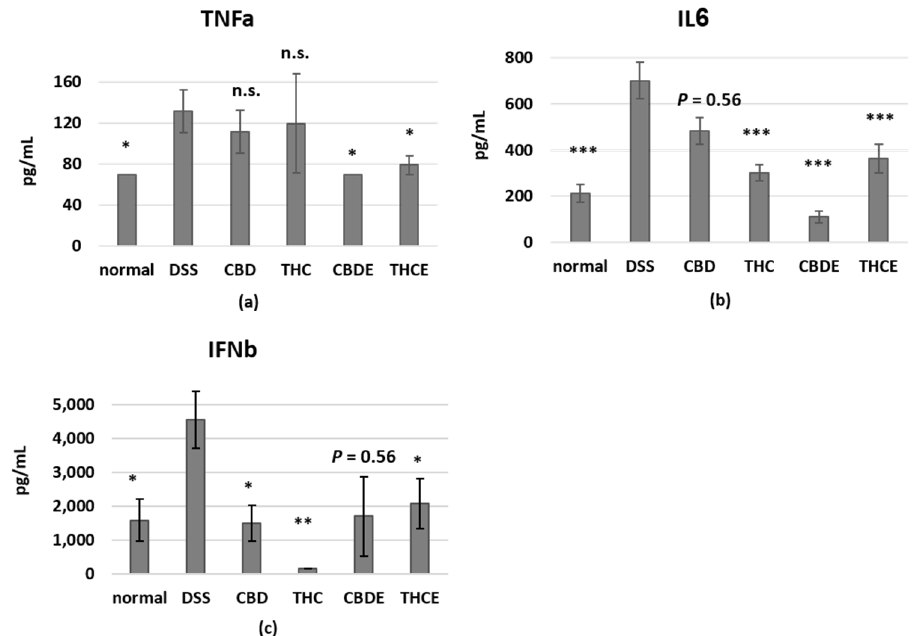
Figure 7. The influence of pure CBD/THC and cannabis extracts on inflammatory cytokines in the blood of DSS model mice. Blood samples for cytokine analysis were obtained at Day 10. The levels of TNFa ( a ), IL6 ( b ), and IFNb ( c ) in the plasma were determined using a LEGENDplex™ Mouse Inflammation Panel cytokine array; n = 5–10 mice/group. The results are expressed as mean + SEM. p -value as compare with the DSS group *, <0.05; **, <0.01; ***, <0.001. DSS—dextran sodium sulfate; high CBD cannabis extract.